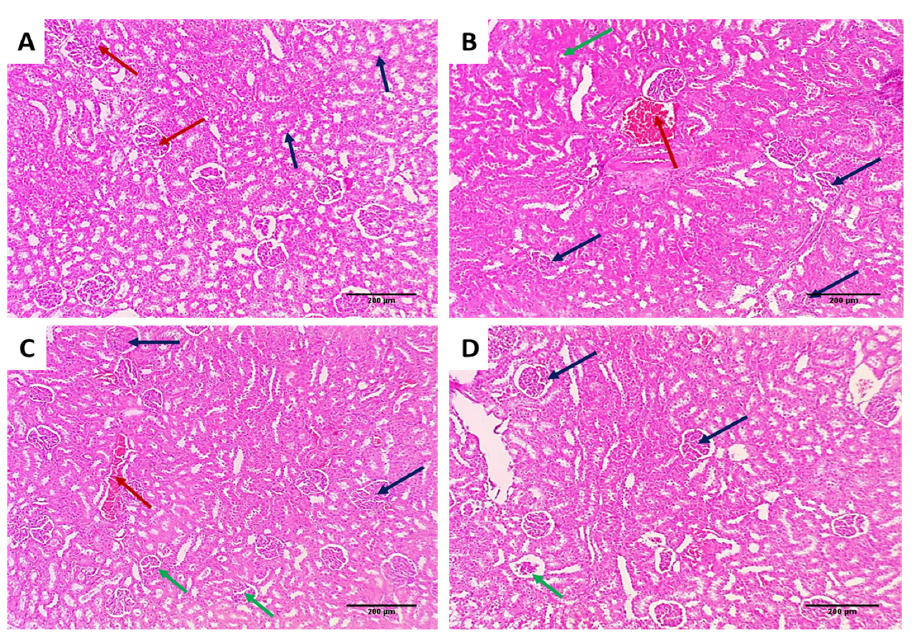
Figure 8. H&E-stained kidney sections of ( A ) normal kidney tissues (negative control) showing average-sized glomeruli (red arrows) surrounded by average-sized tubules lined with columnar cells (blue arrows) (×100); ( B ) group I showing vascular congestion (red arrow) surrounded by atrophic glomeruli (blue arrows) and focal degenerated tubules (green arrow) (×100); ( C ) group II showing focal vascular congestion (red arrow) surrounded by normal-sized glomeruli (blue arrows) and some atrophic glomeruli (green arrows) surrounded by average-sized tubules (×100); ( D ) group III shows average-sized glomeruli (blue arrows) and one atrophic glomerulus (green arrow) surrounded by average-sized tubules (×100).